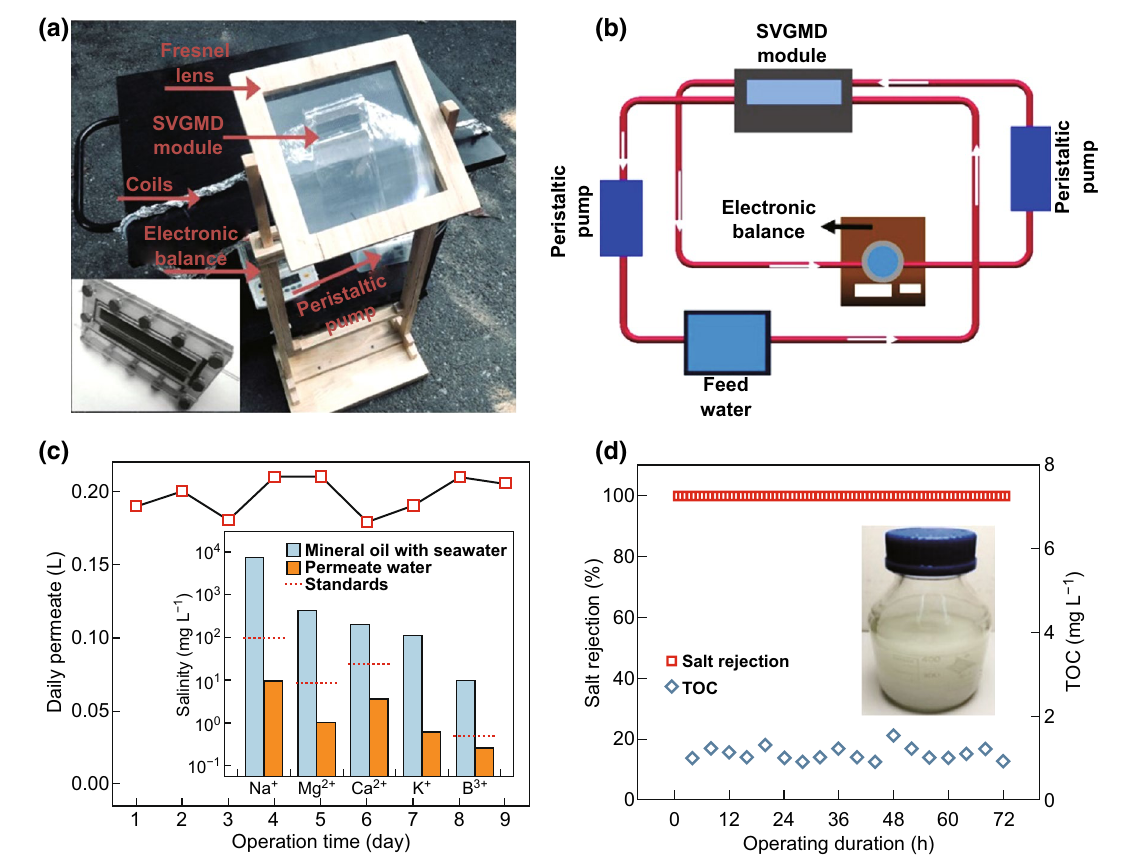
Fig. 5 Scaled SVGMD module demonstrates excellent performance in desalination of mineral oil/seawater mixtures under real-world condi- tions. a Scaled SVGMD system with different components of the system marked with arrows. b Schematic of the SVGMD system. For experi- ments with solar concentration, a 30 × 30 cm 2 Fresnel lens is used to concentrate sunlight on the P–G–Ni foam surface by a factor of 12. c The daily permeate water of outdoor solar experiments with 12 × solar magnification. The inset is the concentrations of five primary ions before (mineral oil/seawater mixtures) and after (permeate water) desalination. d Salt rejection performance and TOC level of permeate water with sea- water mixtures/mineral oil (1 g L −1 mineral oil with natural seawater). The inset shows a typical mineral oil/seawater